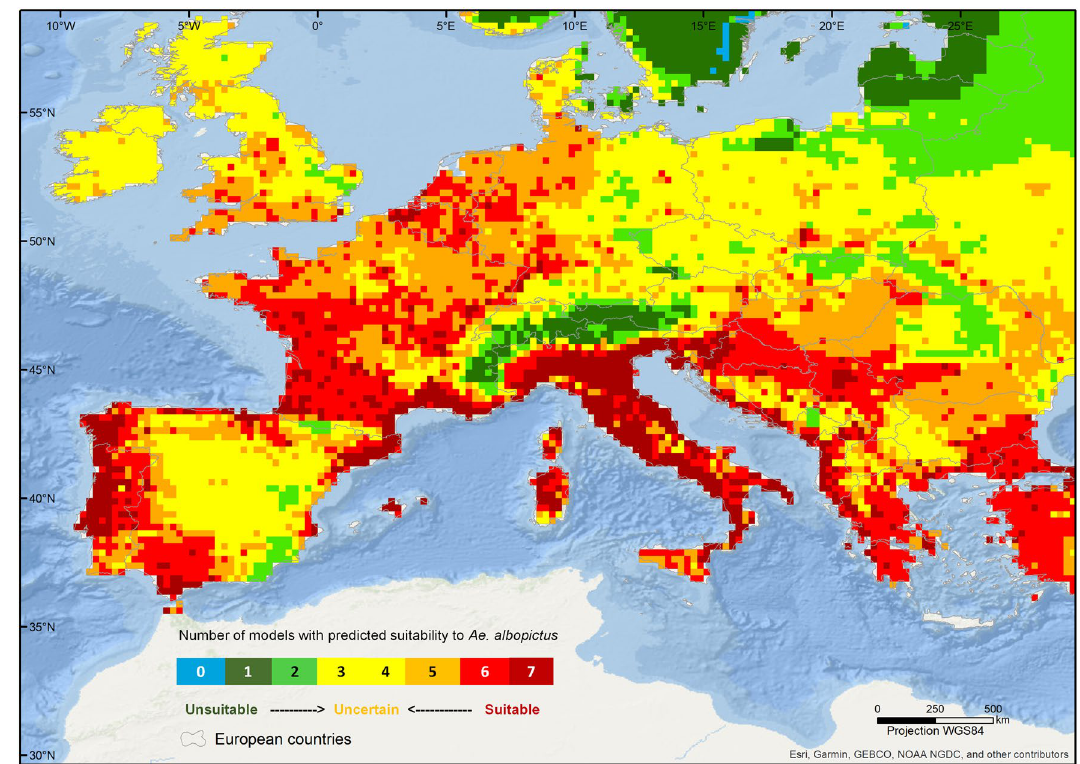
Figure 2. Levels of agreement among published predictions of habitat suitability for Aedes albopictus under present-day conditions. Agreement corresponds to the sum of binary suitability maps, with suitable areas coded as one and unsuitable areas as zero. The map was created using ArcGIS v. 10.6.1 (https:// www. arcgis.